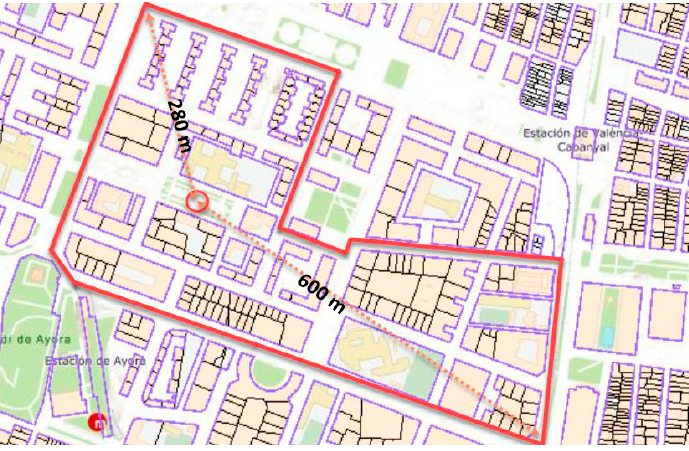
Figure 10. Location of fuel cell in the case of centralized production .